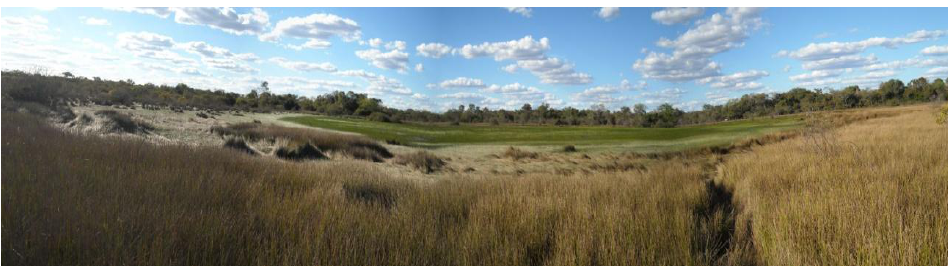
Figure 2. Karst depression covered by herbaceous vegetation and stagnant surface